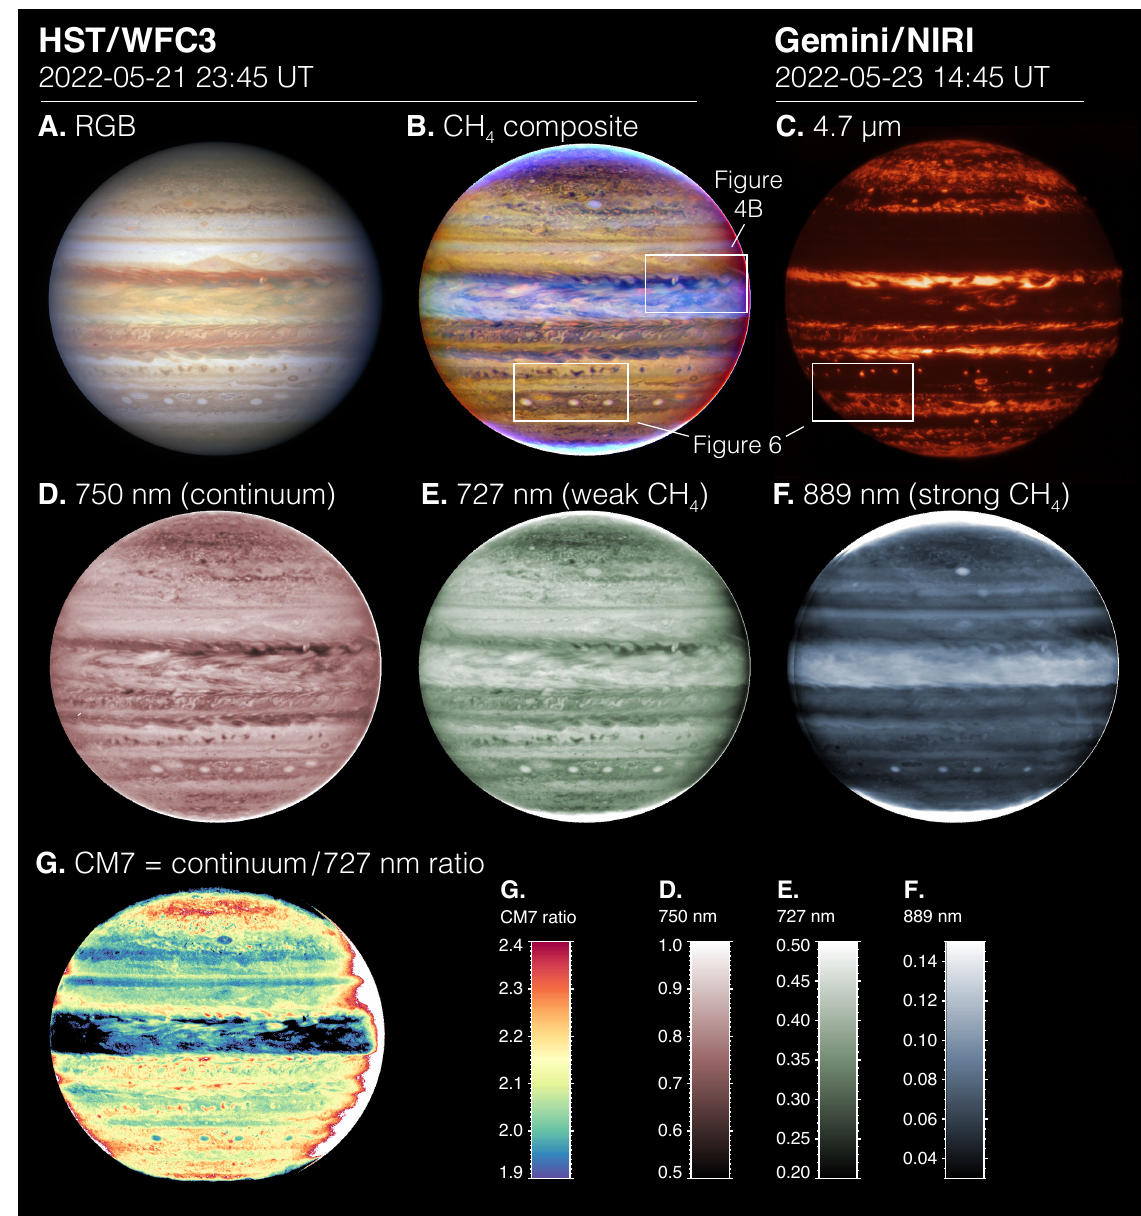
Figure 1. Jupiter imaging data from HST and Gemini observatories map cloud opacity in shallow and deep layers. ( A ) An RGB color image (631, 502, 395 nm) shows Jupiter’s familiar visible appearance. ( B ) A CH 4 -band depth map is composed by loading 750, 727, and 889-nm frames (continuum, weak CH 4 band, strong CH 4 band) into the RGB channels. Deep clouds appear reddish in this color scheme. Boxes outline regions enlarged in Figures 4B and 6. ( C ) Thermal infrared imaging near 5 µ m is very bright where there is no cloud opacity and moderately bright where upper clouds are thin but there is cloud opacity at some level at p < 6 bar [11]. Dark regions have high upper cloud opacity. ( D ) The continuum image is sensitive to cloud opacity across both deep and shallow cloud layers. ( E ) The weak methane band image is sensitive to upper cloud and haze opacity ( p < 3 bar [13]). ( F ) The strong CH 4 band senses aerosols above the condensation clouds at p < 0.6 bar [13]. ( G ) The CM7 ratio (750/727 nm ratio, Equation (1)) is sensitive to the partitioning of upper/lower opacity in multiple cloud layers (while total opacity cancels out in the ratio). High values indicate more opacity at depth, and low values indicate more opacity in the upper cloud